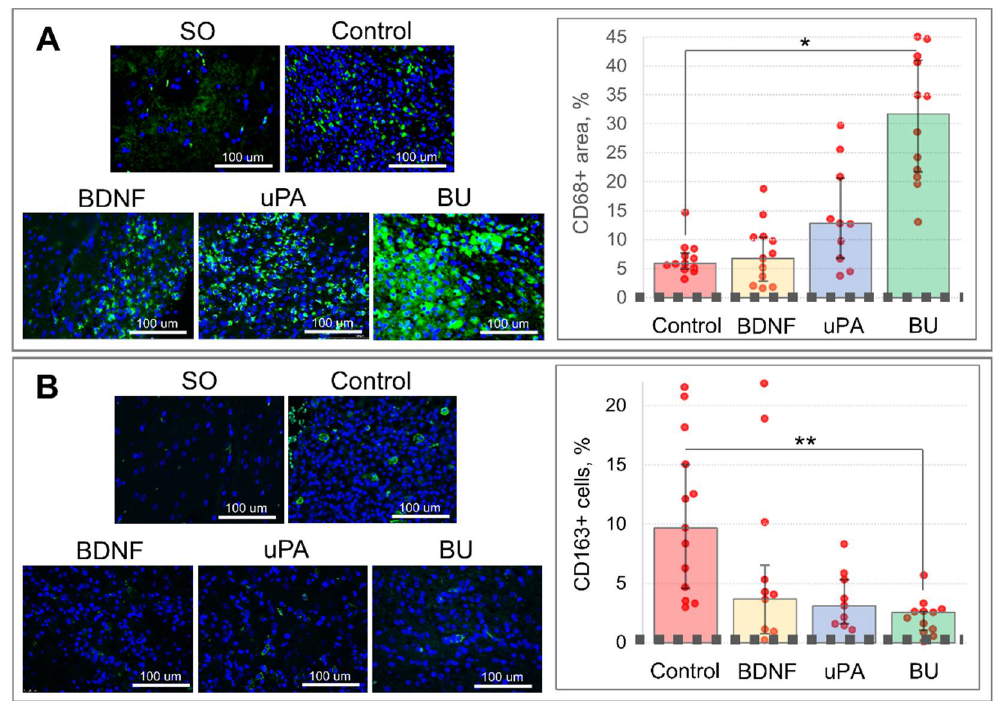
Figure 4. The results of immunohistochemical staining of brain slices 14 days following the intrac- erebral hemorrhage: ( A )—CD68 and ( B )—CD163. On the graphs, the dashed lines correspond to the CD68- or CD163-stained area in the brain slices of sham-operated (SO) animals and the red dots - to the result of individual measurements. The data are presented as the median (25%; 75%). *—H (3, 36) = 25.439, p = 0.001. **—H (3, 32) = 14.998, p = 0.002. BDNF, brain-derived neurotrophic factor; BU, BDNF + uPA; uPA, urokinase-type plasminogen activator.